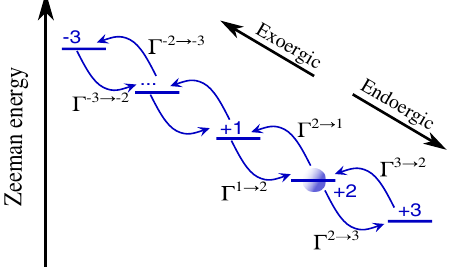
FIG. 8. Sketch of the rate model used for calculating the spin dynamic. For each spin state m , endoergic processes lead to a F; Cs þ 1 state and a gain from the m − 1 state. decay to the m F; Cs F; Cs − 1 Likewise, exoergic SE processes lead to a decay to the m F; Cs þ 1 state and a gain from the m F; Cs